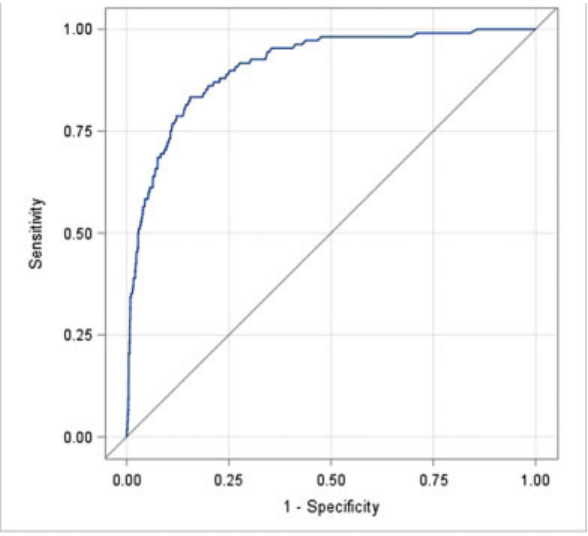
Fig. 3 ROC curve for D-dimer with regard to likelihood of PE. Area under curve is